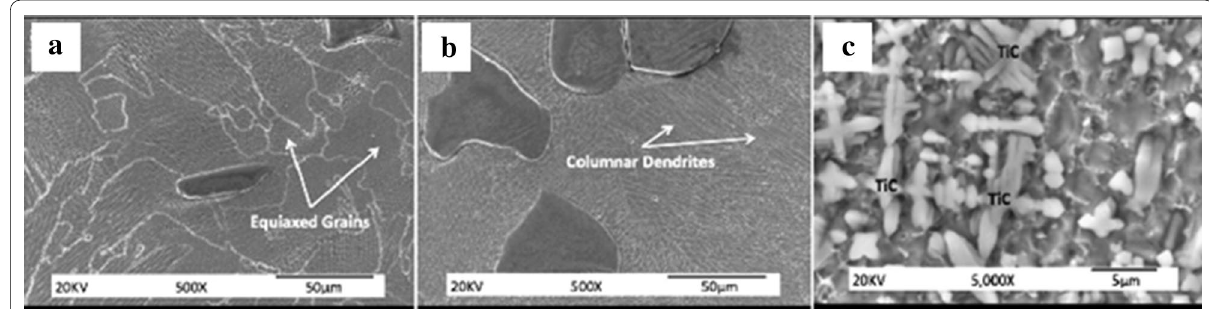
Figure 14 Microstructure of Inconel 690/TiC samples: a Equiaxed grains found in 8.7 vol.% TiC, b Groups of columnar dendrites in 15.3 vol.% TiC layer, c Dendritic TiC phase (43 vol.% TiC) [75]